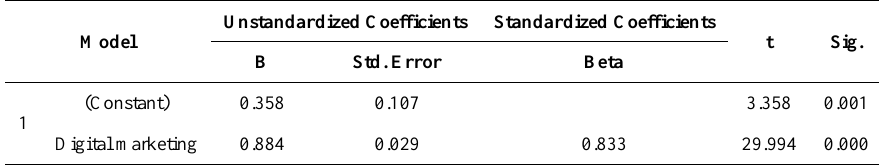
Table 7. OLS Model Coefficients a